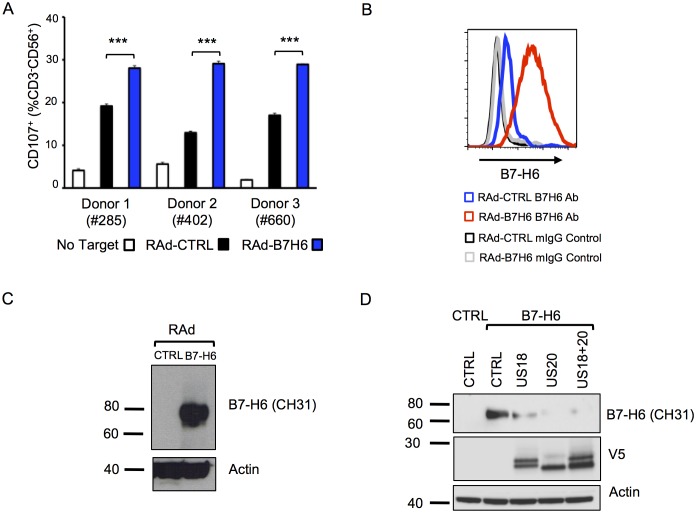
Adenovirus expressed B7-H6 regulates NK cell activation and B7-H6 levels are regulated by ectopically-expressed US18 and US20.(A) HF-CARs were infected with control (RAd-CTRL) or B7-H6-expressing (RAd-B7-H6) adenovirus vectors (MOI 5). Cells were harvested 48 h p.i. and used as targets in a CD107 degranulation assay with buffy-coat derived PBMC from 3 separate donors in duplicate or triplicate. Results (shown as mean and SD) were analyzed by unpaired two-tailed Student’s T-test. ***p<0.001, ****p<0.0001. (B and C) HF-CARs were infected with control (RAd-CTRL) or B7-H6-expressing (RAd-B7-H6) adenovirus vectors (MOI 5). Cells were harvested 48 h p.i. and B7-H6 cell surface expression analyzed by flow cytometry (B) or western blot (C). Results are representative of at least 2 independent experiments. (D) HF-CARs were infected with adenovirus control (CTRL), US18-expressing adenovirus, US20-expressing adenovirus or a combination of both US18 and US20 (MOI 5 each, made up to a total MOI of 10 with RAd-CTRL). After 24 hr incubation, HF-CARs were infected with adenovirus control (CTRL) or B7-H6-expressing adenovirus (B7–H6) at MOI 5 as indicated before incubation for a further 48 hr. Whole cell lysates were prepared and analysed by immunoblotting with the antibodies indicated. Results are representative of two independent experiments.